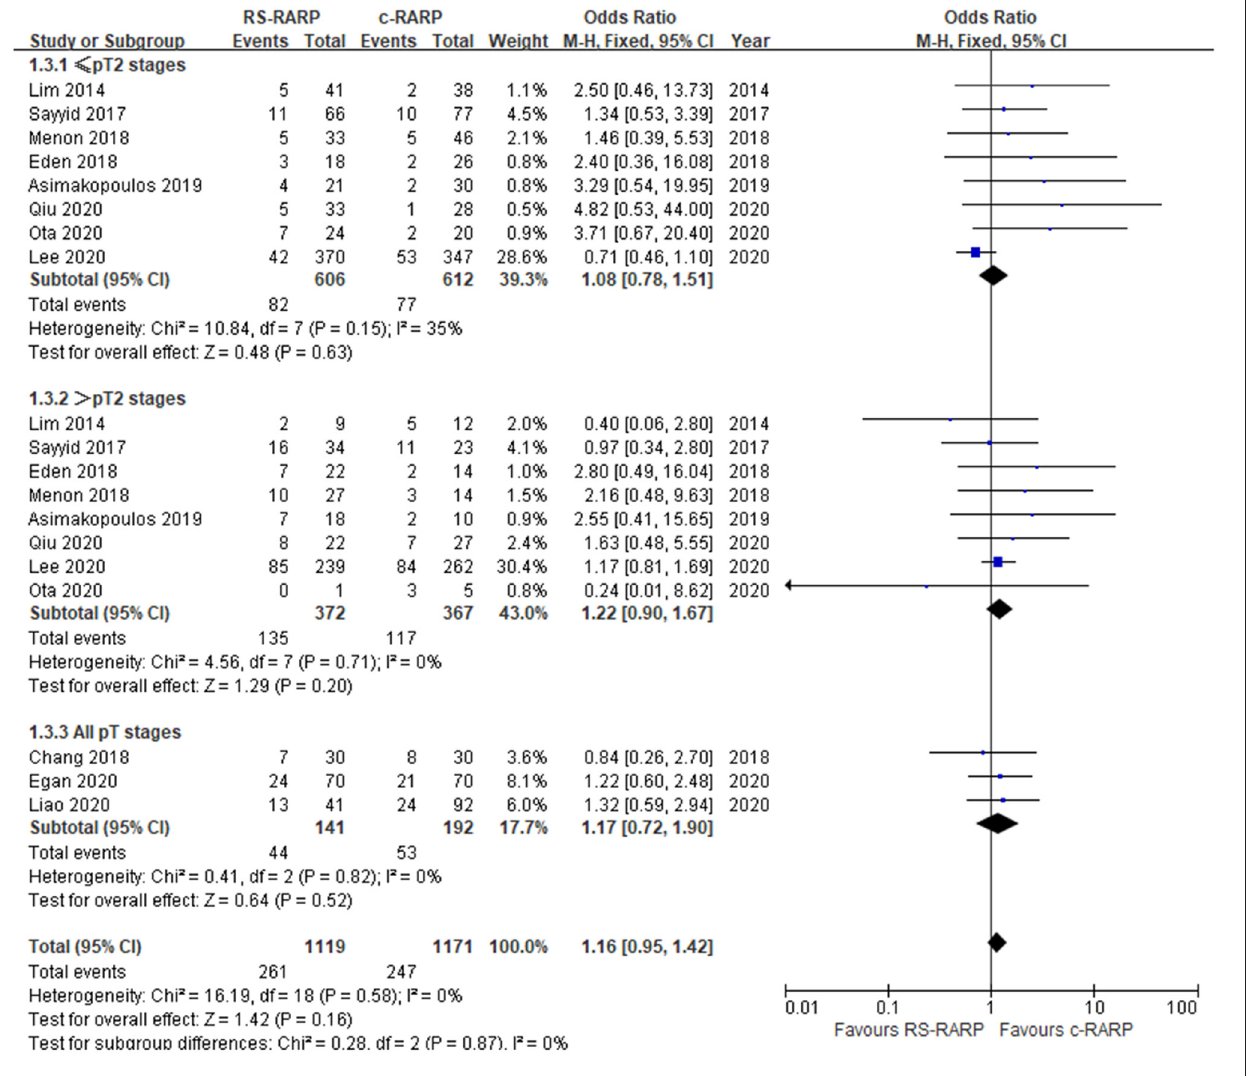
FIGURE 5 | Forest plot of positive surgical